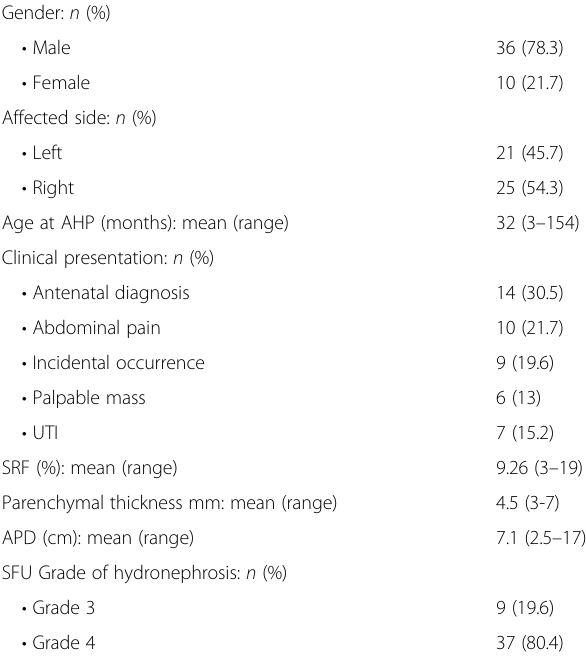
Table 1 Preoperative characteristics of the